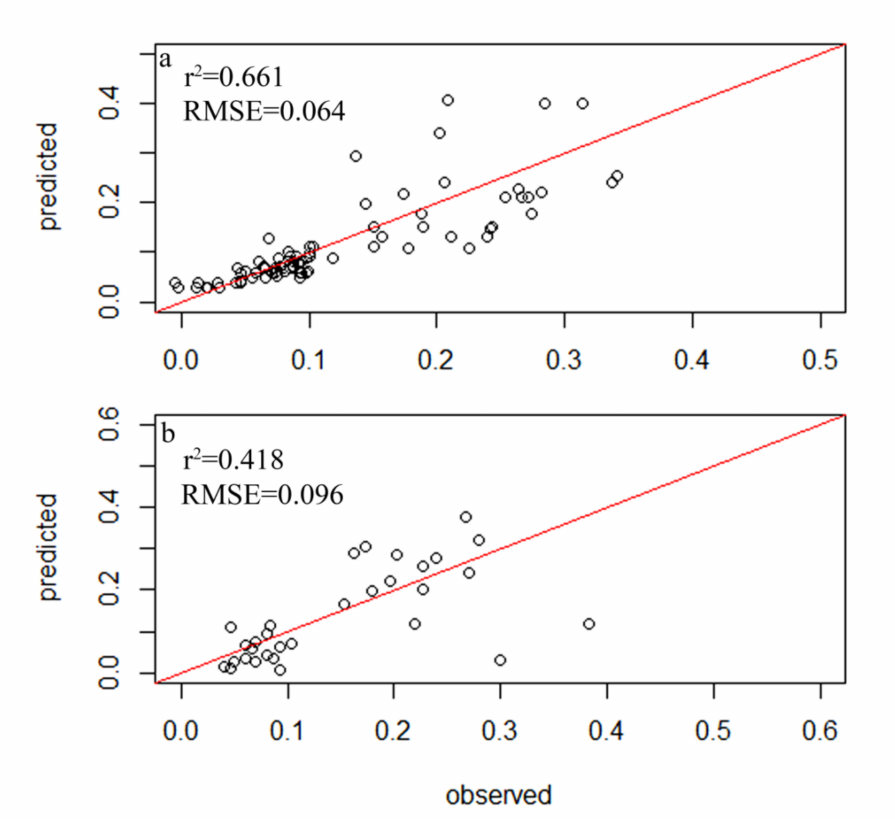
Figure 2. Relationship between the observed and diatom-inferred TP obtained via weighted averag- ing without tolerance down-weighting regression: ( a ) test group; ( b ) control group.